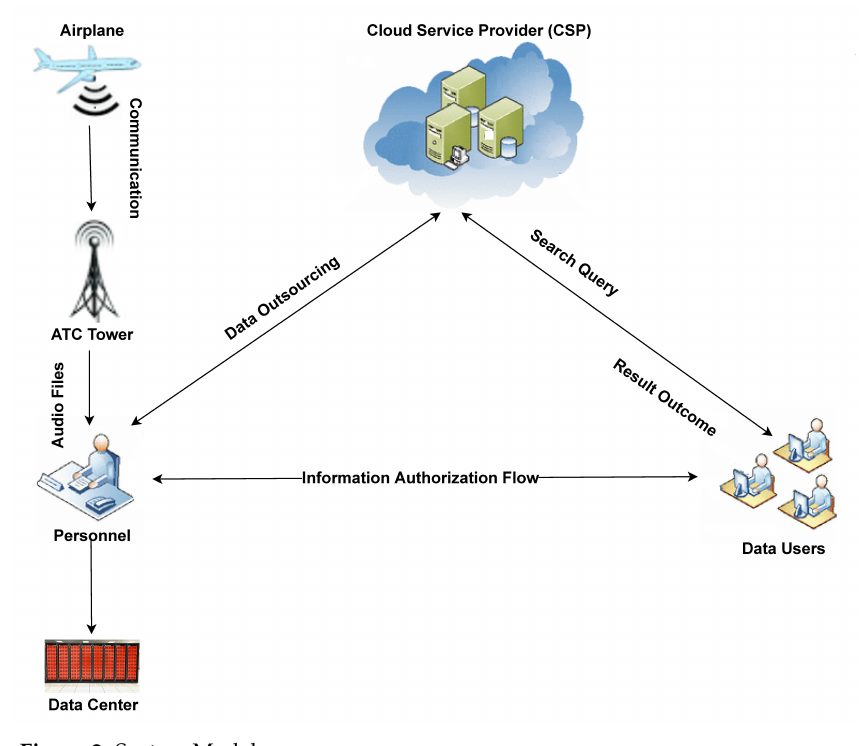
Figure 2. System